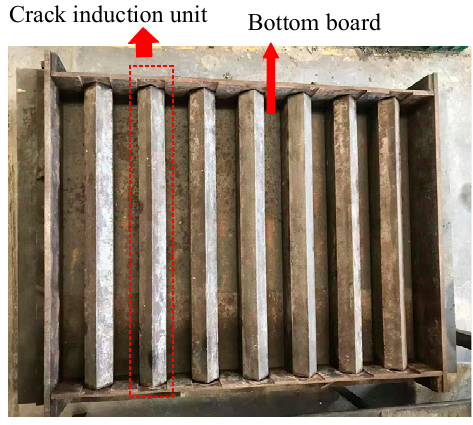
Figure 3. Early-age cracking test instrument. Polymers 2022 , 14 , x FOR PEER REVIEW